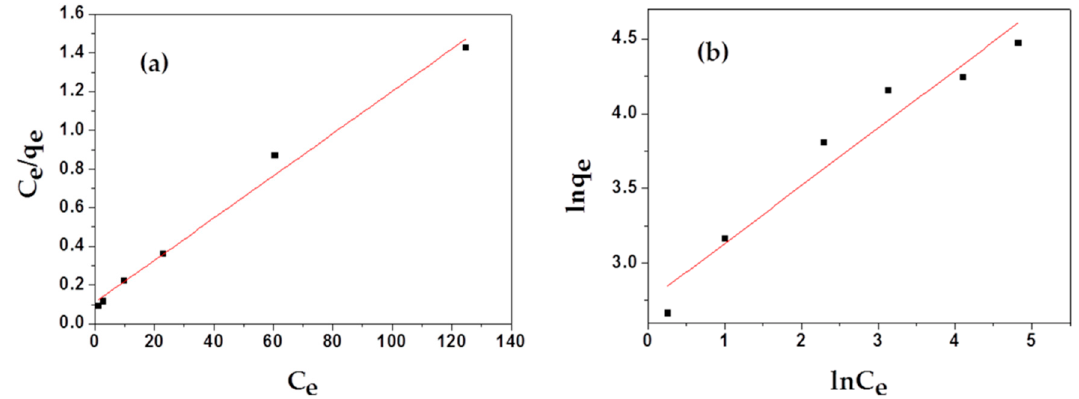
Figure 7. Langmuir ( a ) and Freundlich ( b ) isotherms for the adsorption of MAFC to emulsified